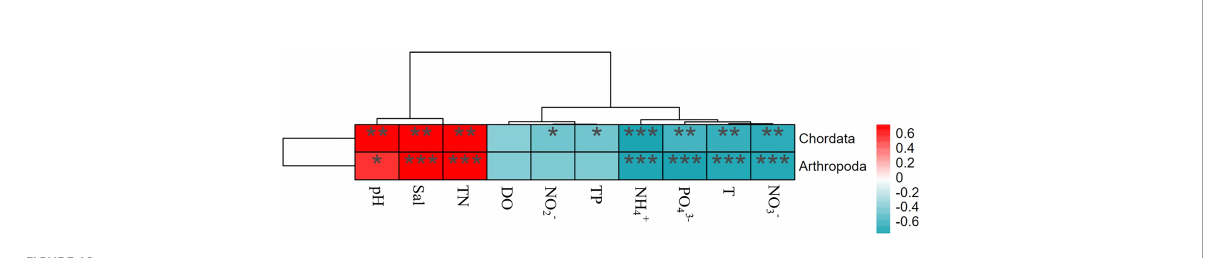
FIGURE 10 Correlation analysis between attached organisms and environmental factors (N-ARs). Colours represent positive and negative correlations (red represents positive correlation; blue represents negative correlation). Asterisks indicate signi fi cant correlations (*** P < 0.001; ** P < 0.01; and * P < 0.05). Environmental codes are as follows: temperature (T), salinity (Sal), dissolved oxygen (DO), active phosphate ( P − PO 3 − 4 ), nitrite ( N − NO − 2 ), nitrate ( N − NO −